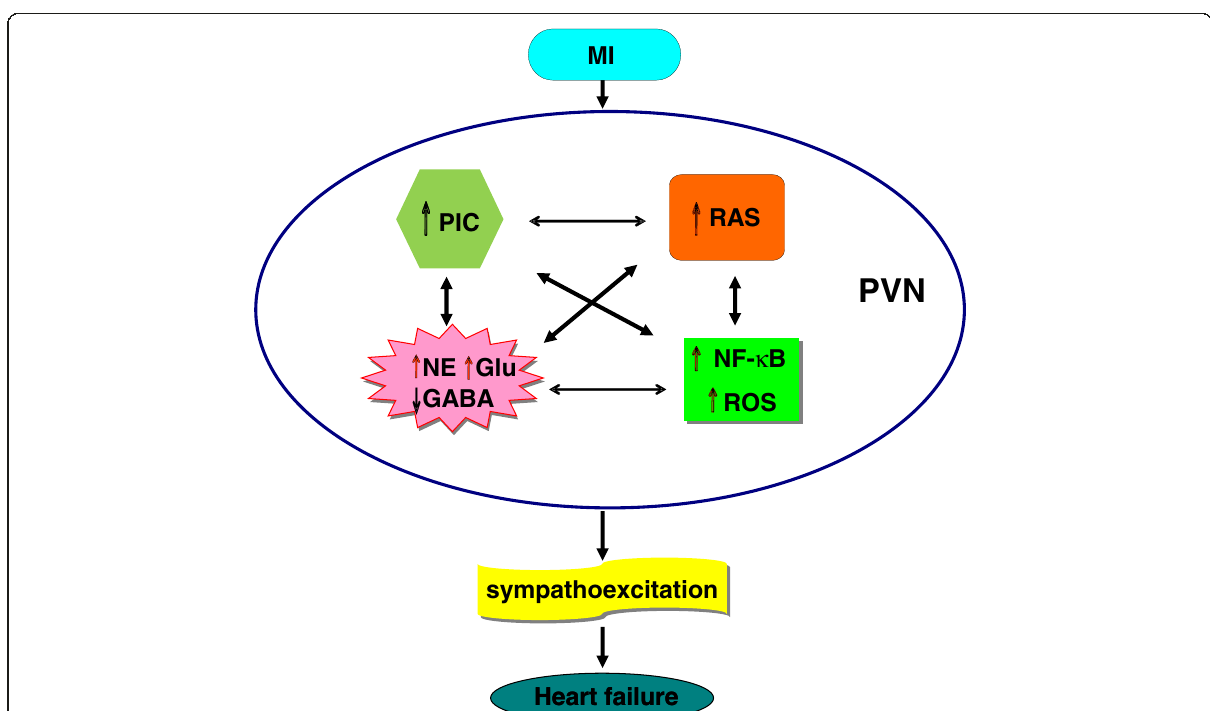
Figure 1 The interaction among RAS, PICs, ROS, NF- κ B and neurotransmitters in the PVN contributes to sympathoexcitation in heart